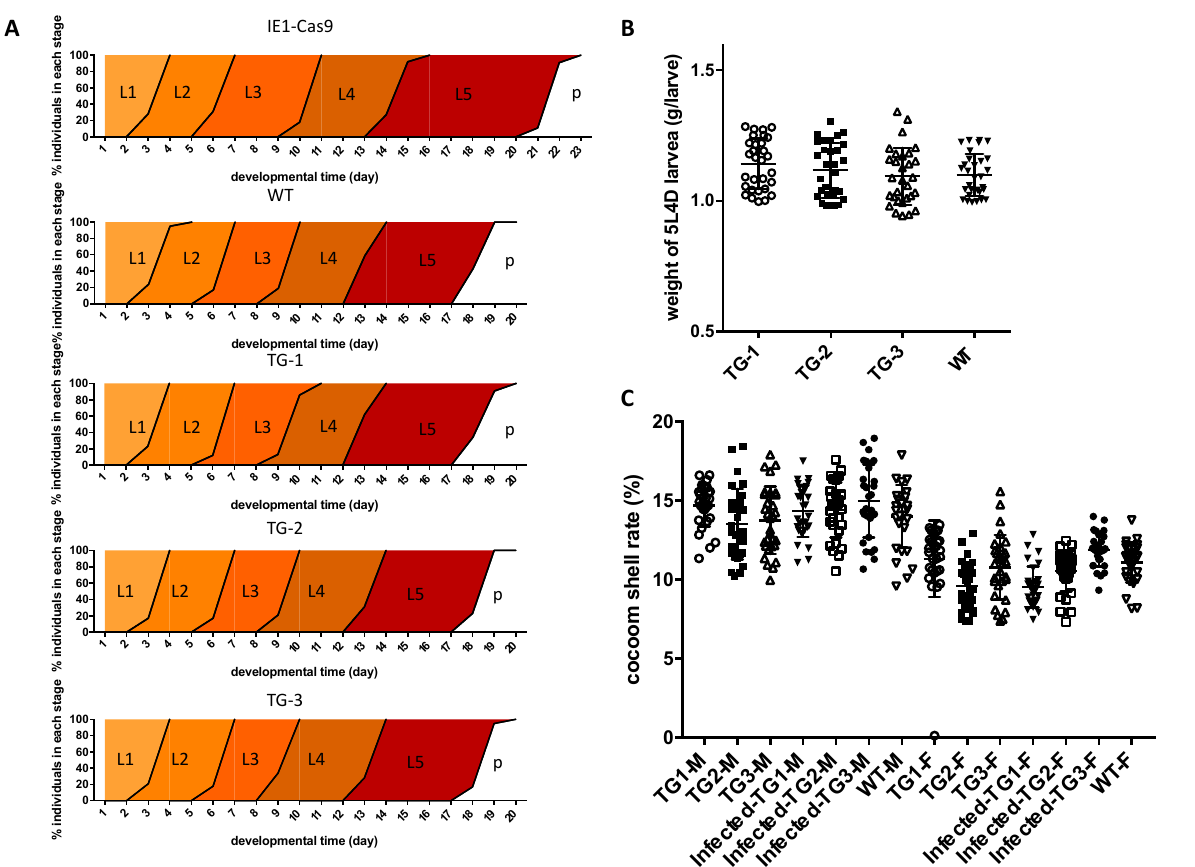
Figure 7. Economically important characteristics transgenic silkworms. ( A ) The timing of larval development in the virus-inducible transgenic, IE1-Cas9 transgenic, and WT silkworms (L1, first instar; L2, second instar; L3, third instar; L4, fourth instar; L5, fifth instar; p , pupae). ( B ) Body weights of 5L4D transgenic silkworm larvae and WT larvae (200 larvae from each group were evaluated). ( C ) Cocoon shell rate of the transgenic and WT lines. The infected TGs were the transgenic silkworms that survived after inoculation with 1 × 10 6 OBs/larva. Each value represents the average of 30 larvae per group (M, male; F, female).